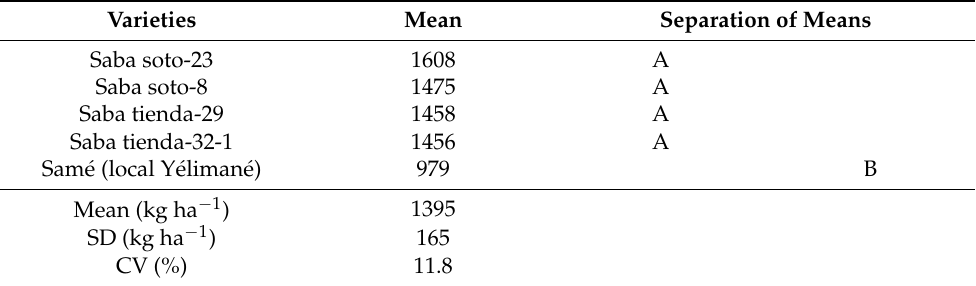
Table 7. Average sorghum straw yield (kg ha − 1 ) across sites of flood recession farming for five varieties tested in Yaguine, Gory, and Foungou in the 2015/2016 cropping season. Varieties Mean Separation of Means Saba soto-23 5163 A Saba tienda-32-1 4738 A B Saba soto-8 4138 B C Saba tienda-29 3475 C D Sam é (local Y é liman é ) 3063 D Mean (kg ha − 1 ) 4115 SD (kg ha − 1 ) 667 CV (%) 16.2 A, B, C, D: values in the Sam é column with different letters are significantly different at p = 0.05. SD: standard deviation; CV: coefficient of